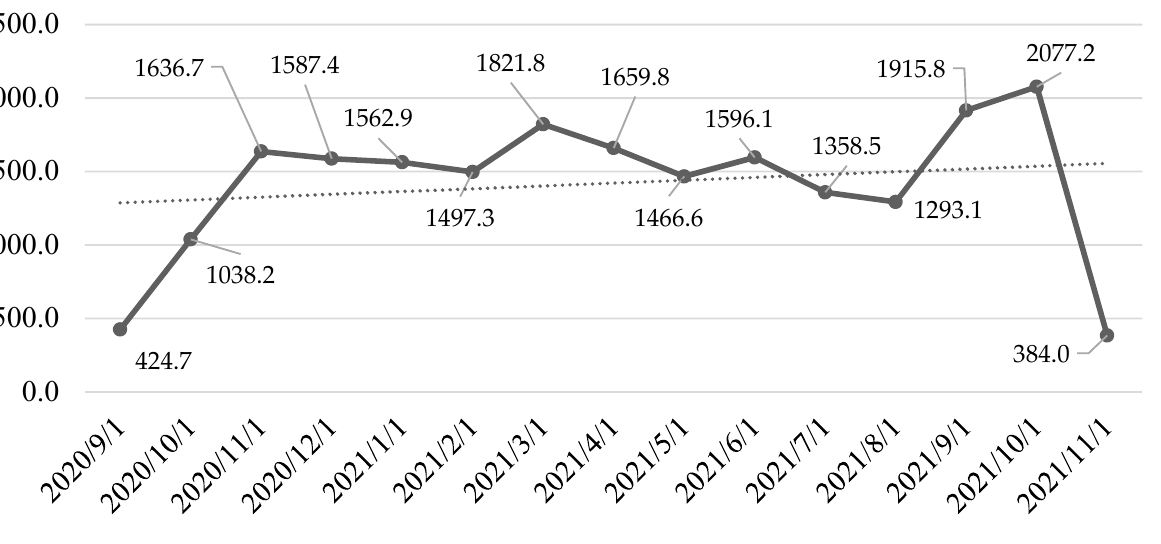
Figure 2. Dynamics of the index “Responsibility and openness” (MRRT) for the whole period of its calculation, 1 September 2020—1 November 2021, RUB billion. Source: Compiled by the authors based on the Moscow Exchange (2021).